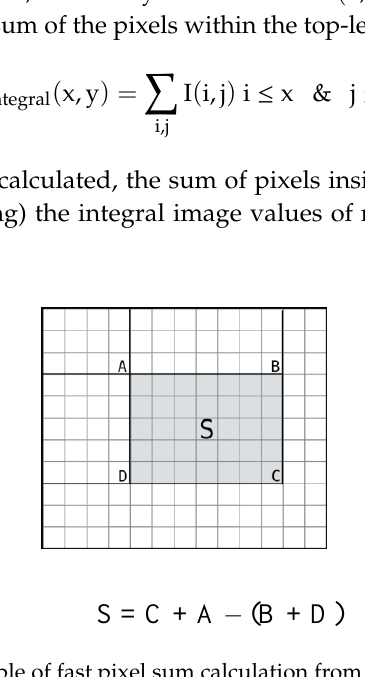
Figure 11. Example of fast pixel sum calculation from the integral image.